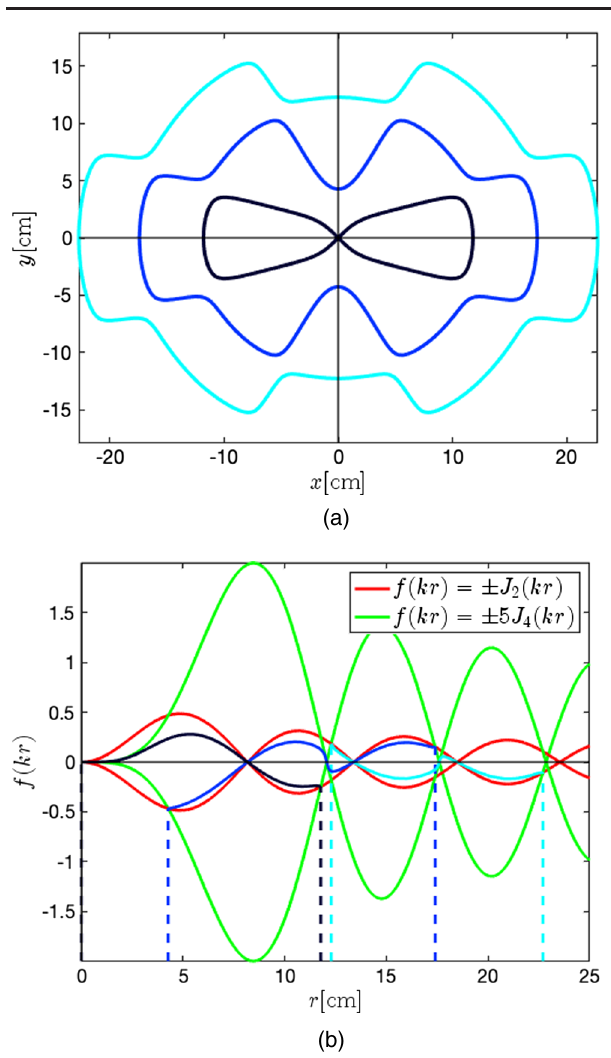
modes with ˜ g 4 = ˜ g 2 ¼ 5 , ϕ 4 ¼ 0 . f 2 ; 4 g η 0 η Þ θ Þ , that support the η ¼ 1 , 2, and 3 0 ð